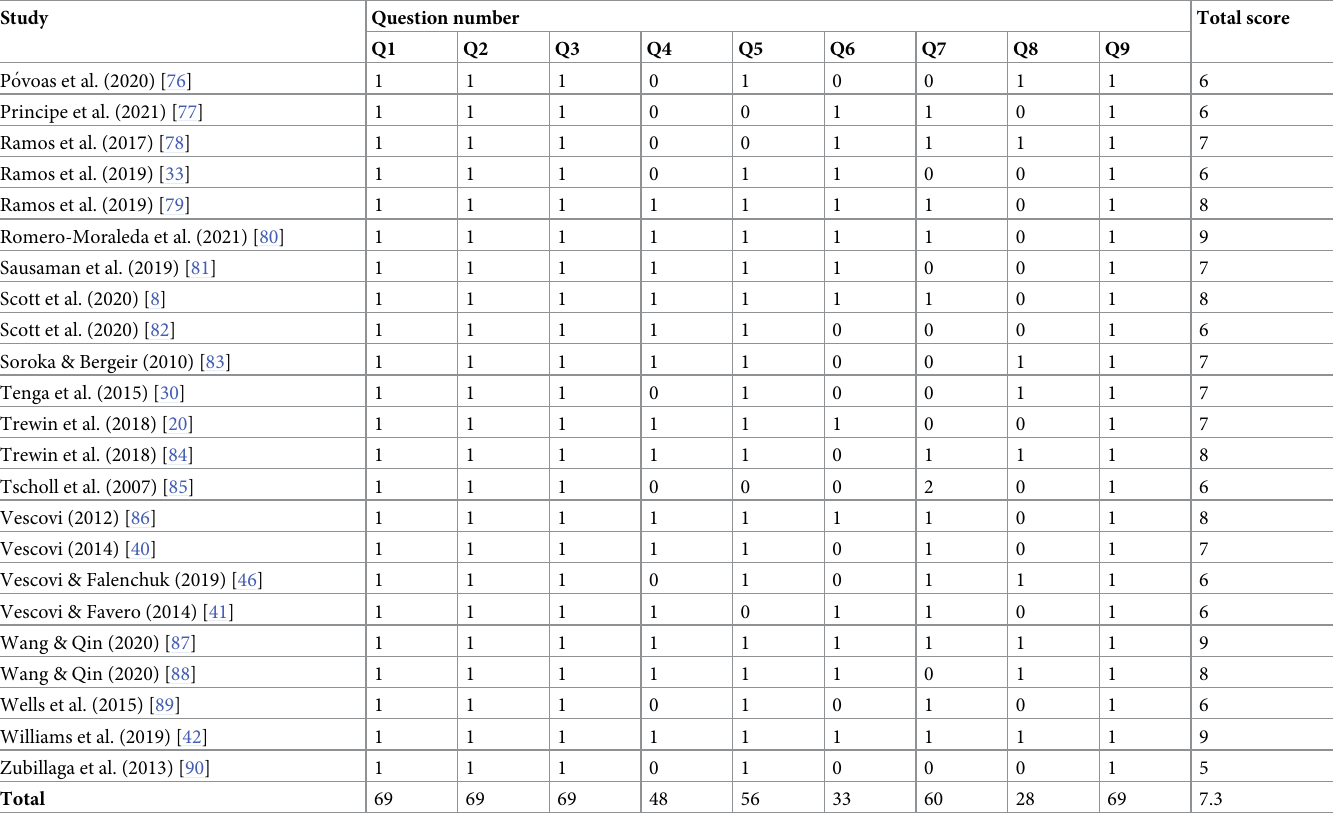
(19%) quantified the impact of contextual variables on physical characteristics; environmental factors (e.g. altitude, temperature [36, 49, 84]), quality of opposition [38, 84], match outcome [46, 84], type of competition [50], match location [46], congestion of fixtures [71, 84], playing surface [46], stage of season [89], and stage of menstrual cycle [63]. Of the 26 studies which categorised players by playing position; 9 studies utilised high-level categorisation (i.e. defenders vs midfielders vs forwards) [38, 40, 41, 43, 44, 57, 77, 81, 86]; 7 studies differentiated central and wide defenders and midfielders (i.e. central defenders vs wide defenders vs central midfielders vs wide midfielders vs forwards) [19, 26, 33, 51, 52, 74, 80]; 5 studies differentiated central and wide defenders only (i.e. central defenders vs wide defenders vs midfielders vs forwards) [20, 45, 73, 78, 79]; 2 studies differentiated central and wide defenders and forwards/attackers (i.e. central defenders vs wide defenders vs midfielders vs central attackers vs wide attackers) [69, 70]; 1 study categorised wide players together (i.e. central defenders vs central midfielders vs wide players vs forwards) [62]; and 1 study differen- tiated central midfielders (i.e. central defenders vs wide defenders vs central attacking mid- fielders vs central defensive midfielders vs wide midfielders vs forwards) [8]. Three studies included goalkeepers within analysis [8, 62, 74]. A variety of velocity thresholds have been adopted within the 40 studies which categorised movement into velocity zones. The quantitative velocity thresholds are presented in Table 5. Four studies also quantified backwards running ( > 10 km � h -1 ) [35, 43, 44, 65]. The methods for establishing or adopting velocity thresholds included; arbitrary velocity thresholds